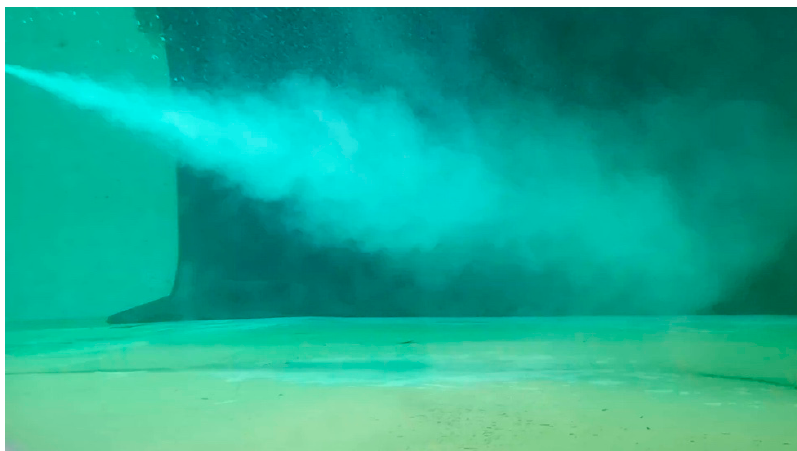
Figure 9. Bubble plume generated by the KTM pump in the tow tank.